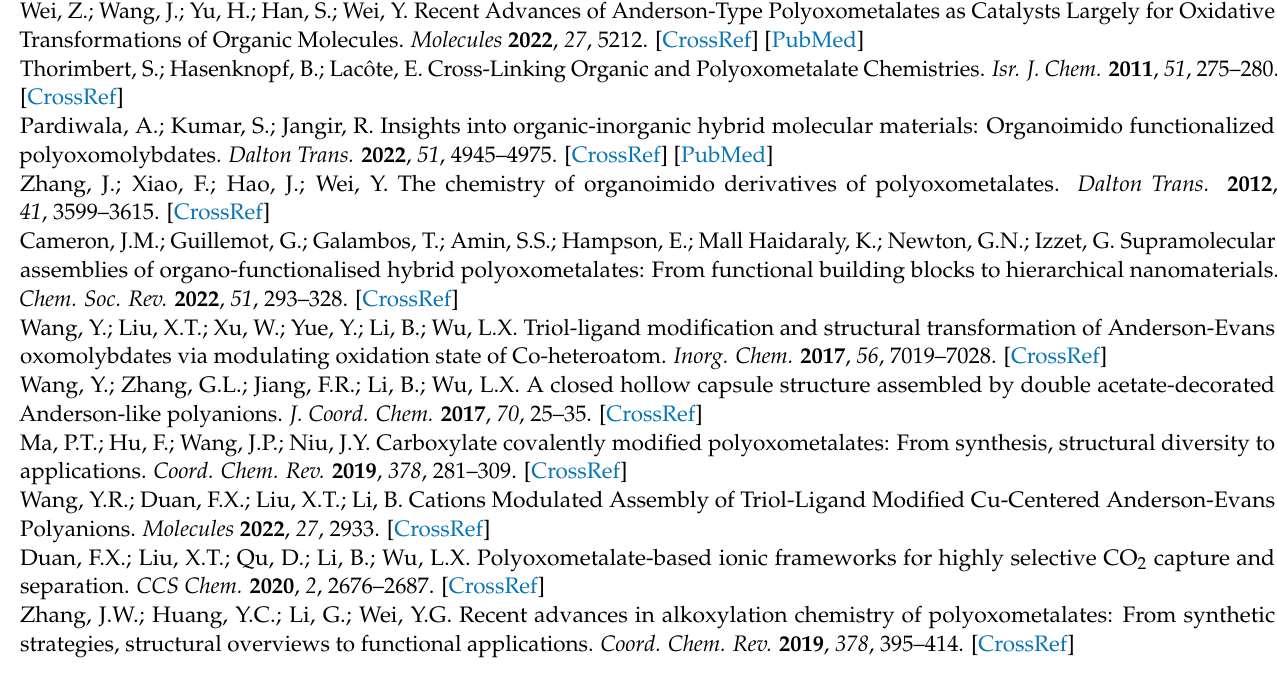
conformations; Figure S3: The packing model of polyanion of compound 1 along a axis, showing a double-layer structure; Figure S4: FT-IR spectra of compounds 1 and 2 ; Figures S5 and S6: XPS spectra for Mo and V of compounds 1 and 2 ; Figure S7: PXRD patterns of the as-synthesized and simulated for (a) compound 1 , and (b) compound 2 ; Figure S8: TGA curves of compounds 1 and 2 ; Figure S9: 1 H NMR spectra of triol ligand TME and compound 1 after its dissolving in water for different amounts of time; Figure S10. 1 H NMR spectra of triol ligand TMP and compound 2 after its dissolving in water for different amounts of time; Figure S11: Linear fitness of ln( σ T) versus 1/T of compounds 1 and 2 ; Table S1: Important bond lengths in the cluster of compound 1 ; Table S2: Important bond angles in the cluster of compound 1 ; Table S3: Important bond lengths in the cluster of compound 2 ; Table S4: Important bond angles in the cluster of compound 2 ; Table S5: The proton conductivity performance of different